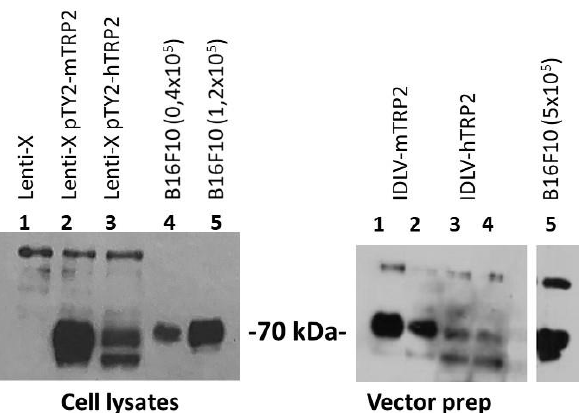
Figure 6. Expression of murine and human TRP2 evaluated by Western blot. Left panel: Detection of TRP2 in cell lysates of Lenti-X cells (1 × 10 5 ) transfected with plasmids expressing either mTRP2 or hTRP2. Lenti-X and B16F10 cell lysates were used as negative and positive control of TRP2 expression, respectively. Right panel: Detection of TRP2 in concentrated vector preparations (3 × 10 6 RT/lane). The rabbit anti-TRP2 polyclonal antibody used to detect the expression of TRP2 recognizes both human and murine TRP2 proteins.